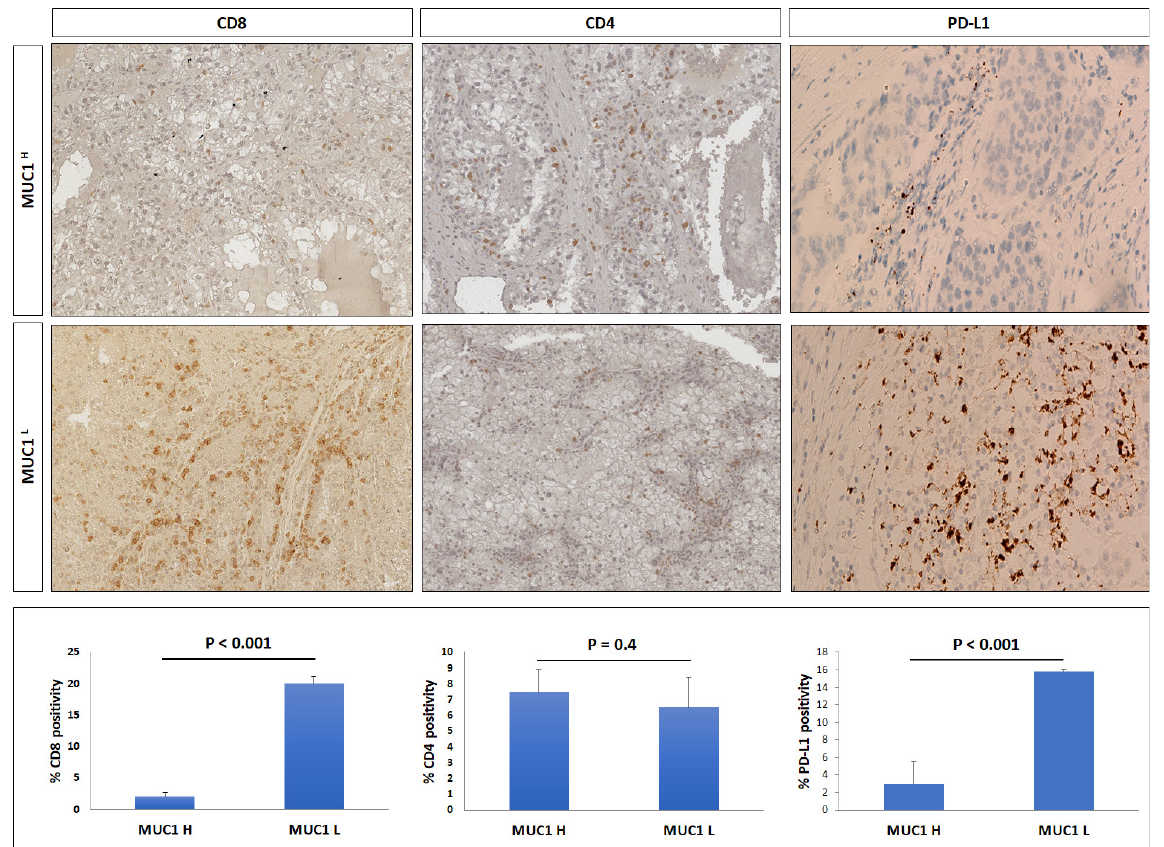
H ccRCC compared